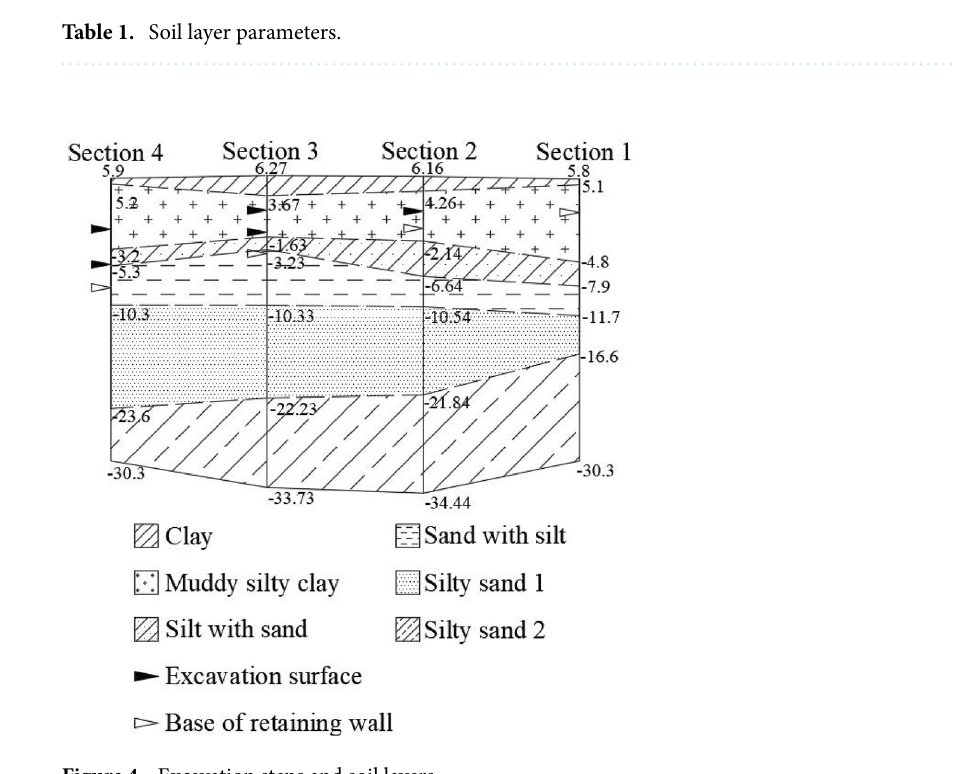
Figure 4. Excavation steps and soil